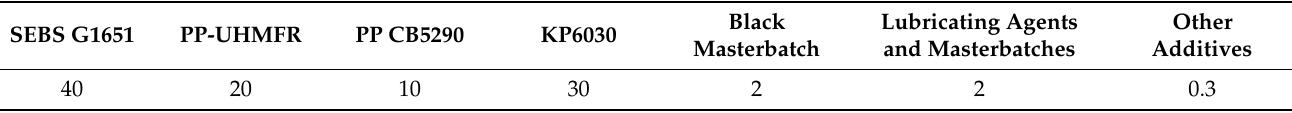
Table 11. Formulas of various lubricating agents and masterbatches.